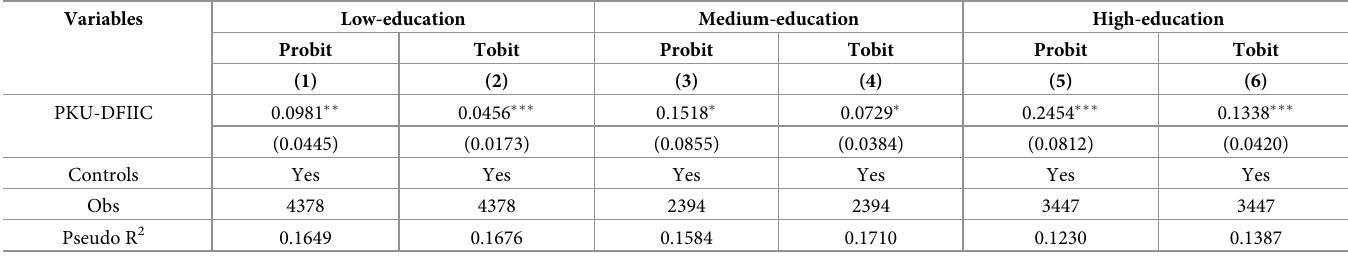
Table 5. Heterogeneity analysis 2: Education level. Variables